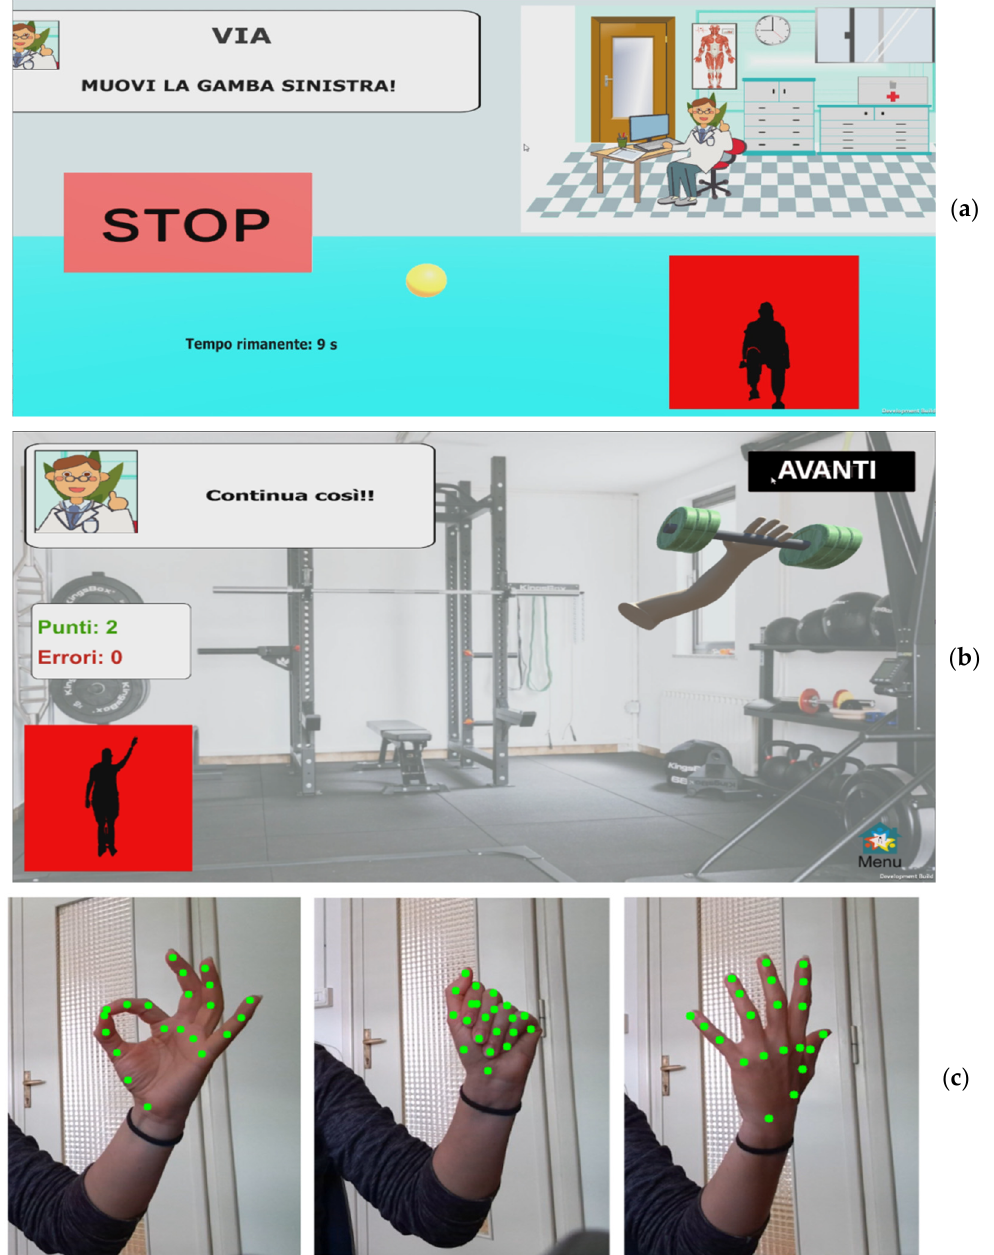
Figure 4. Example of a GUI for a LA task ( a ), FWL exergame ( b ), and upper limb tasks ( c ).